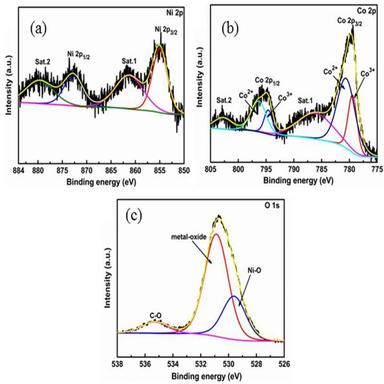
The XPS spectrum has been labelled as (a) indicates the biniding energy of 2p orbitals of NiO, (b) indicates the binding energy of 2p orbital of Co3O4 of A(NC) nanocomposites, whereas (c) indicates the binding energy of O 1s orbital of nanocomposite (NiO/Co3O4) and C-O respectively.